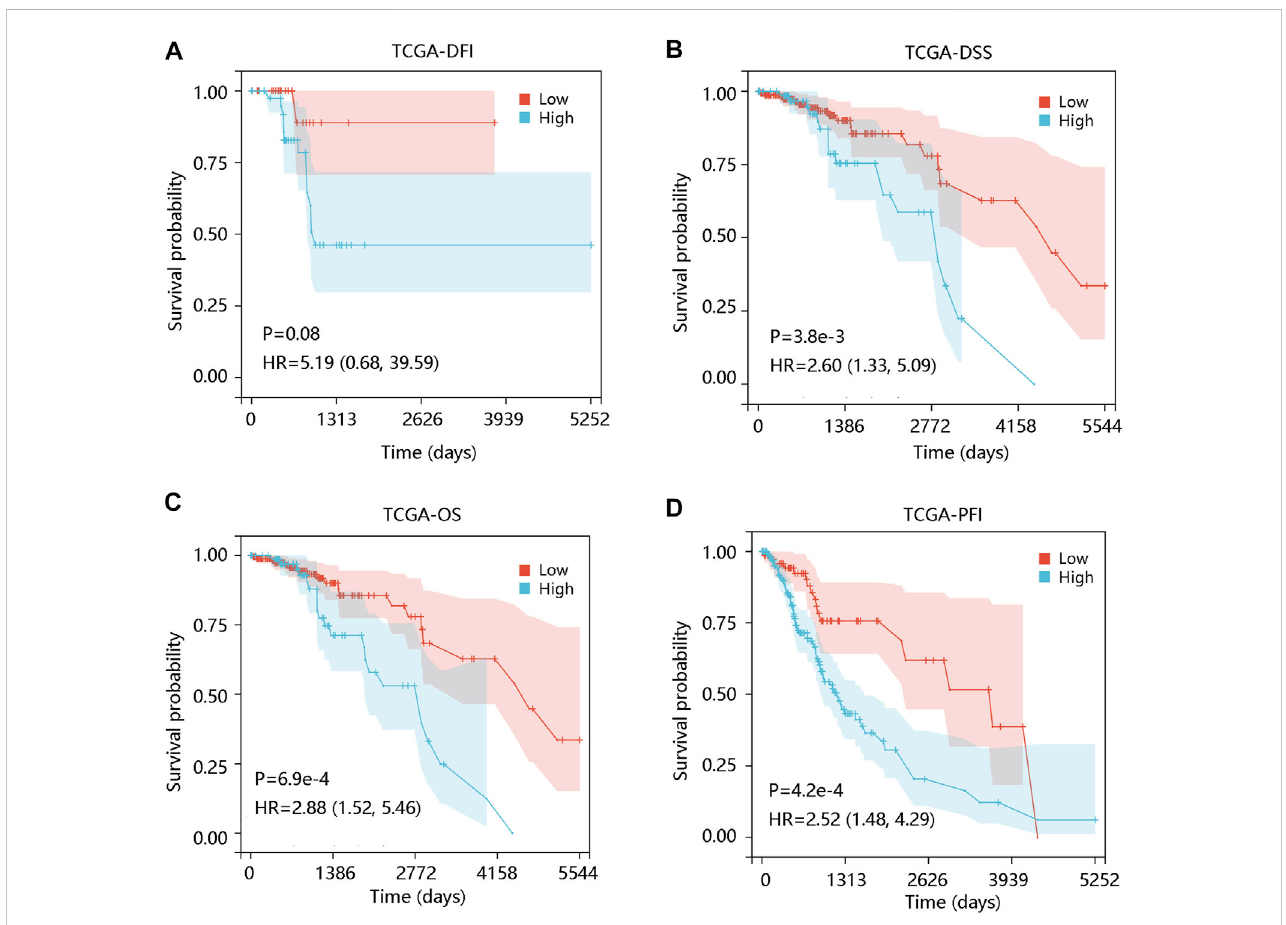
FIGURE 2 The association of ALOX5 expression with prognosis in low-grade glioma using the TCGA-LGG data. (A) High ALOX5 expression had no remarkable effectonDFI.HighALOX5expressionledtoworse (B) DSS, (C) OS,and (D) PFI.DFI,disease-freeinterval;OS,overallsurvival;PFI,progression-freeinterval;HR, hazard ratio.